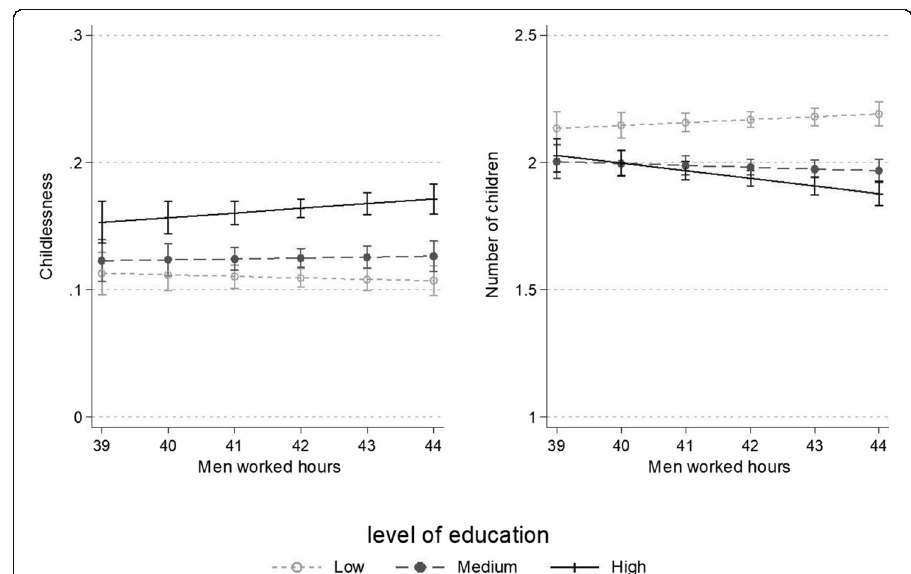
Fig. 3 Predicted probabilities of being without children (left) and predicted number of children (right) by average hours worked by men on the main job and female level of education. Source : EU-LFS 2005-2010, author ’ s elaboration. Note : Predictions refer to Tables 10 and 11 in the Appendix, models C3c and N3c. Ninety percent confidence intervals displayed